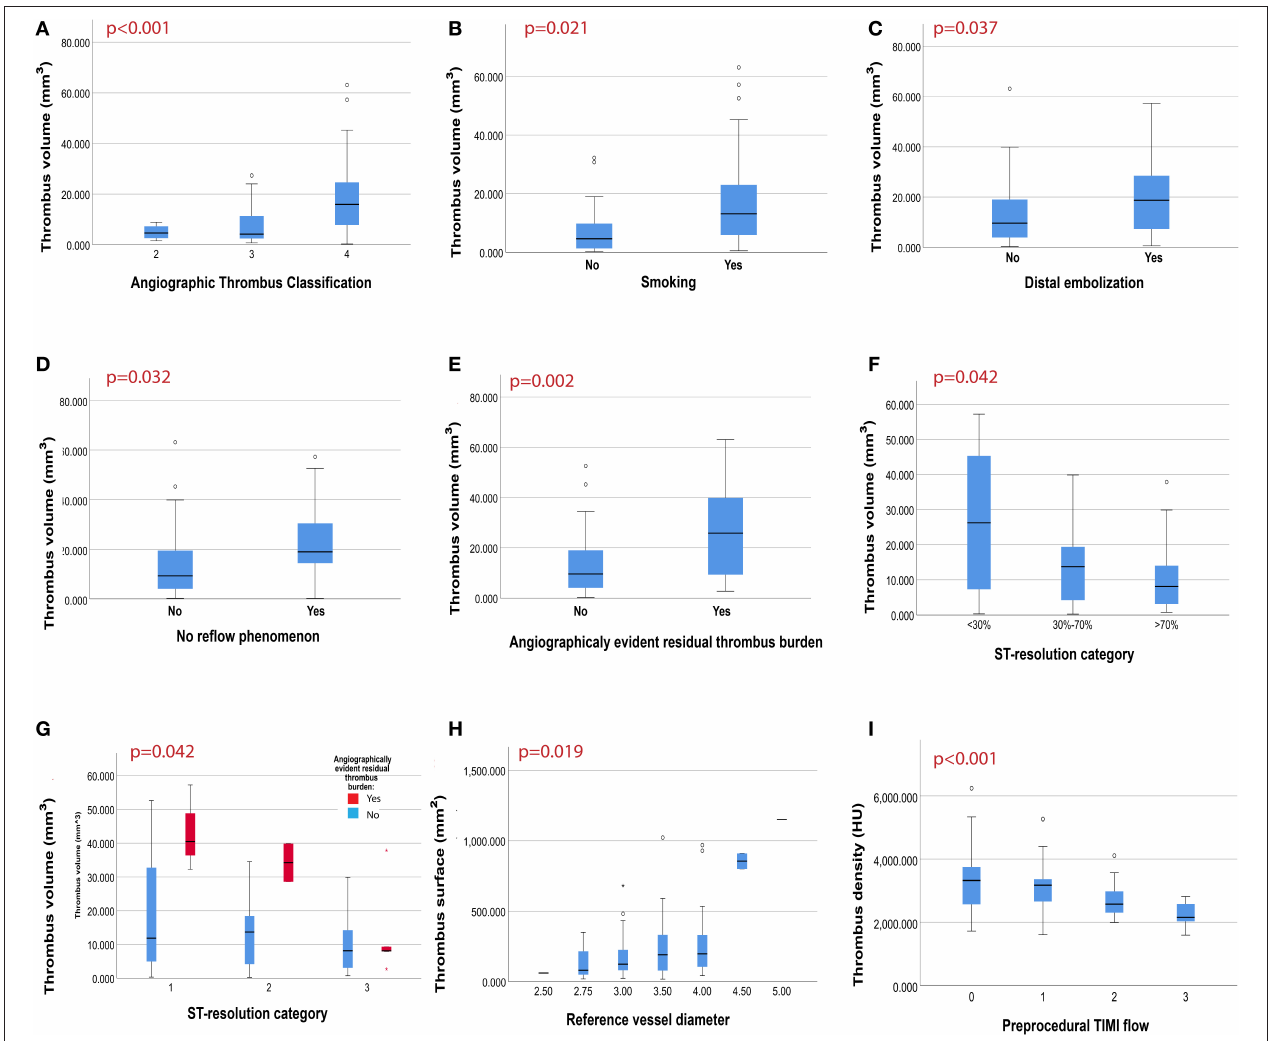
FIGURE 3 | Main findings of the QUEST STEMI study. (A) Association of thrombus volume with angiographic thrombus classification by modified TIMI thrombus grade classification [Grade 2: 4.64 (2.66–8.92) mm 3 , Grade 3: 4.21 (3.72–8.80) mm 3 , Grade 4: 15.94 (10.60–19.51) mm 3 ]. (B) Association of thrombus volume with smoking history [yes: 13.14 (9.31–16.35) mm 3 , no: 4.64 (2.66–8.69) mm 3 ]. (C–E) Association of thrombus volume with angiographic outcomes { (C) distal embolization [yes: 18.70 (9.27–24.52) mm 3 , no: 9.61 (6.61–13.82) mm 3 ], (D) no-reflow phenomenon: [yes: 18.98 (15.79–32.26) mm 3 , no: 9.31 (6.61–13.65) mm 3 ], and (E) angiographically evident residual thrombus [yes: 25.81 (9.31–39.87) mm 3 , no: 9.61 (6.61–13.65) mm 3 ]}. (F,G) Association of thrombus volume with electrocardiographic outcomes [complete ST resolution; 8.12 (5.93–10.31) mm 3 , partial ST resolution; 13.74 (6.42–16.97) mm 3 and absent ST resolution: 26.26 (7.31–45.26) mm 3 ]. (H) Association of thrombus surface with reference vessel diameter [RVD: 2.5 mm: 150.30 ( ± 175.22) mm 2 , 3 mm: 187.54 ( ± 152.22) mm 2 , 3.5 mm: 233.21 ( ± 198.23) mm 2 , 4 mm: 539.17 ( ± 1388.82) mm 2 , 4.5 mm: 855.73 ( ± 78.26) mm 2 ]. (I) Association of thrombus density with pre-procedural TIMI flow [TIMI 0: 3322 (3023–53523) HU, TIMI I: 3171 (2863–3331) HU, TIMI II: 2574 (2307–3564) HU, TIMI III: 2152 (2019–2594)